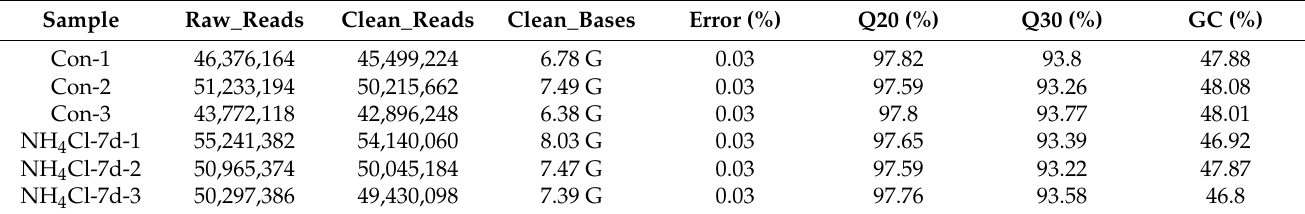
Table 2. Quality assessment of the sequencing data.